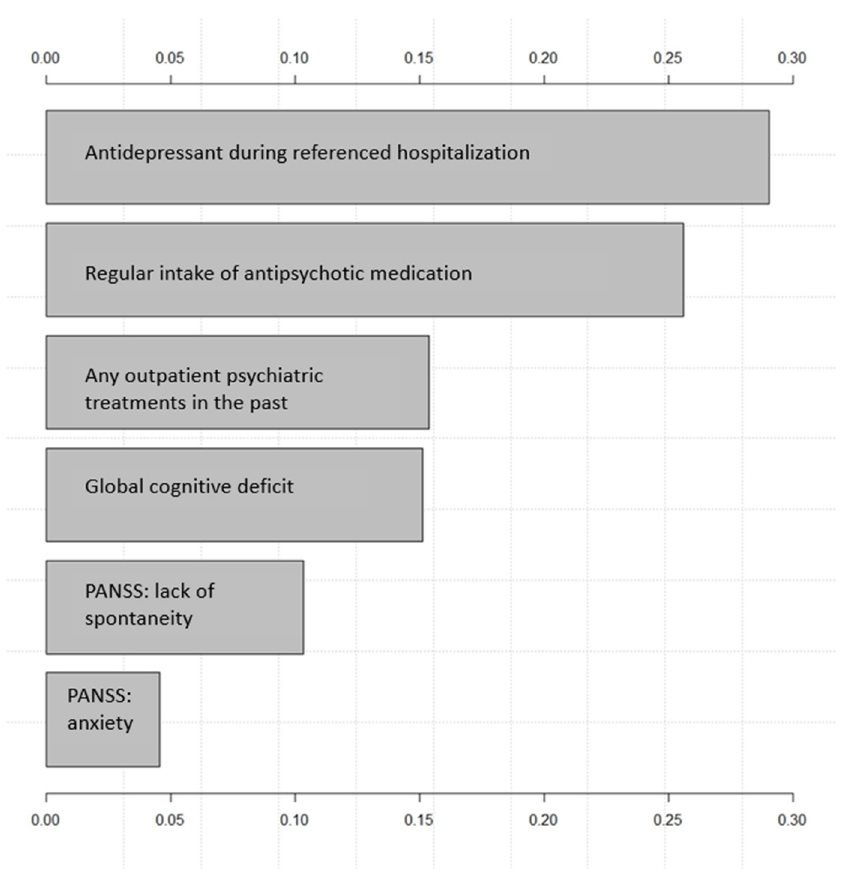
Figure 2. Importance of variables by naïve bayes. PANSS refers to adapted PANSS as described in the methodology section. the methodology